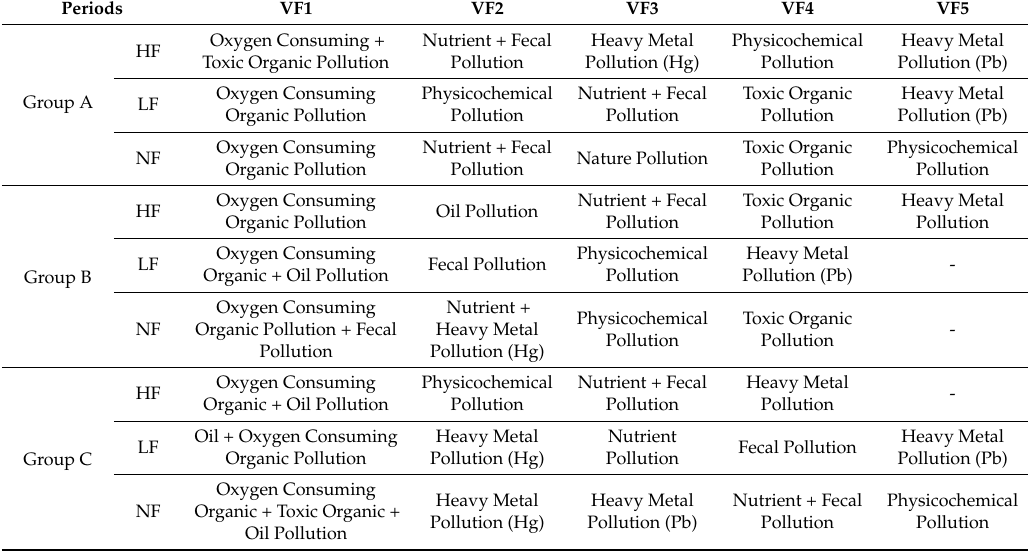
Table 5. Source apportionment results for each period for the three different regions of pollution.